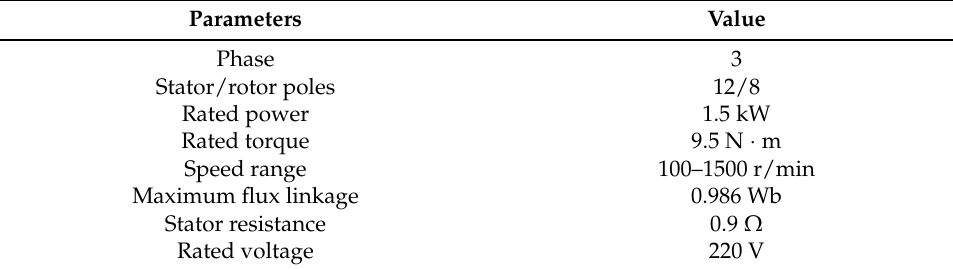
Figure 5. Experimental platform. Table 1. Motor prototype